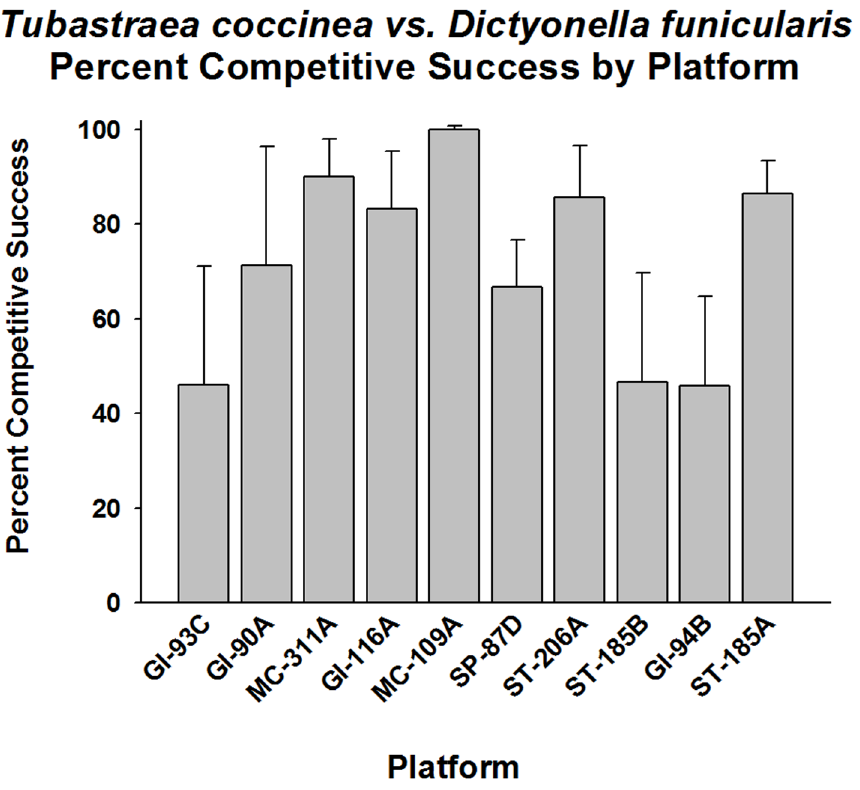
Fig 8. Percent of competitive success in competition for space between Tubastraea coccinea and Dictyonella funicularis , by platform. Mean plus 95% confidence limits shown. Range of number of interactions per platform (n): 13 – 83. See Fig 2 legend for additional details. Overall competitive successes significantly higher than 50% (p < 0.001, Fisher ’ s Exact Test). Highly variable win frequencies between platforms. Platforms exhibiting significant competitive success were GI-90A, MC-311A, GI-116A, MC-109A, SP-87D, and ST-185A (p < 0.01 – 0.001, Goodness of Fit Test, G-statistic). The remainder exhibited no significant difference with a 50% competitive success level (p >